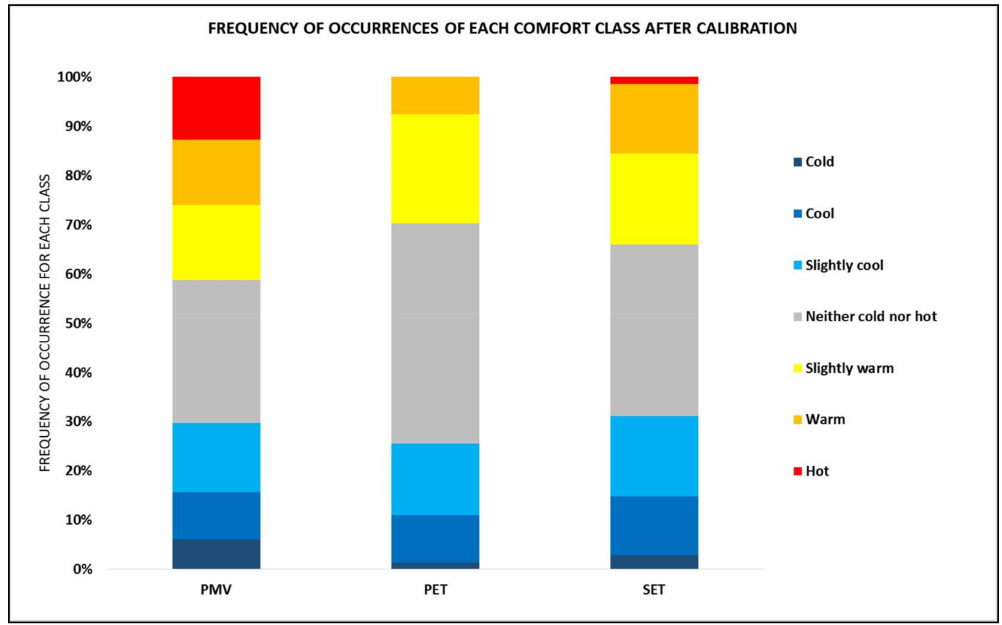
Figure 3. Frequency of occurrences relative to each interpretive range after calibration across the entire analyzed